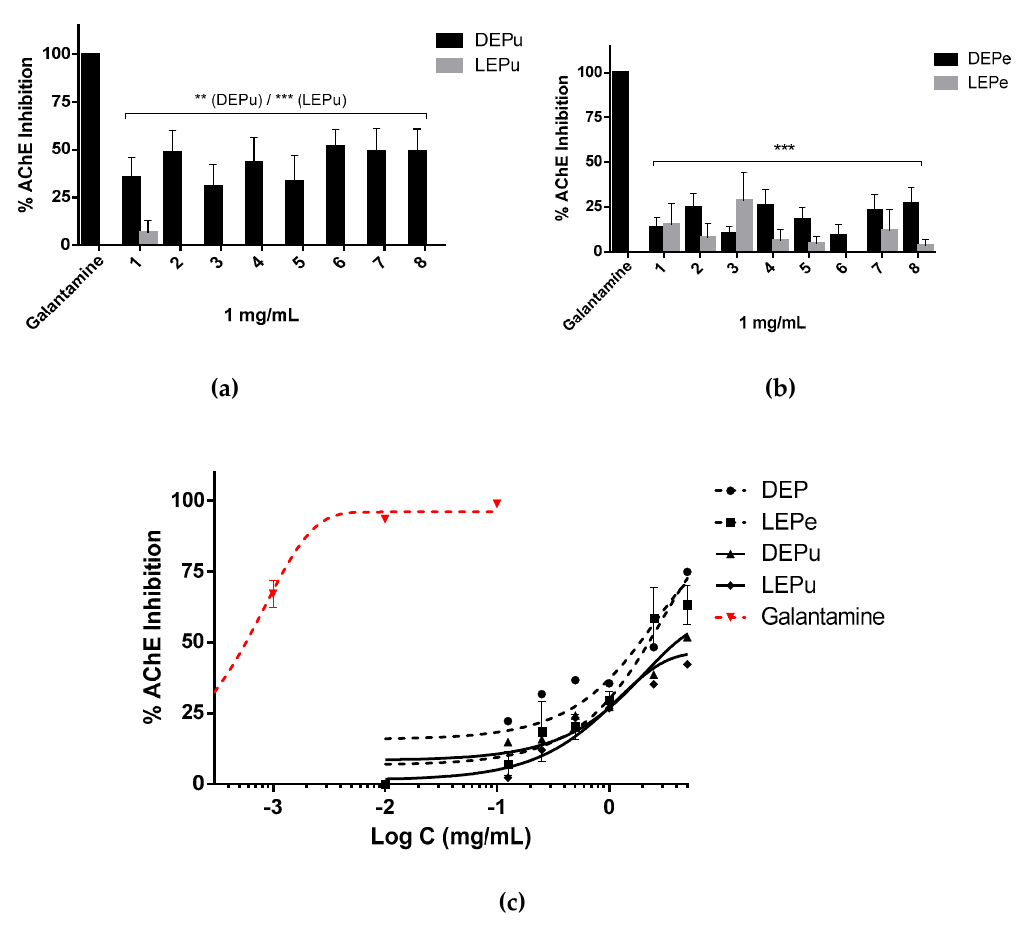
Figure 4. AChE inhibition: ( a ) inhibition performed by extracts obtained from pulp ( n = 3); ( b ) inhibition performed by extracts obtained from peel ( n = 3); ( c ) inhibition performed by sample 5 for DEPe and DEPu, sample 6 for LEPe and LEPu, and galantamine in a concentration dependent manner ( n = 3). One ‐ way analysis of variance (ANOVA) followed by Dunnet’s test for multiple comparisons: ** p < 0.01; *** p < 0.001 against galantamine. DEPe: dried peel methanolic extract; LEPe: lyophilized peel methanolic extract; DEPu: dried pulp methanolic extract; LEPu: lyophilized pulp methanolic extract.